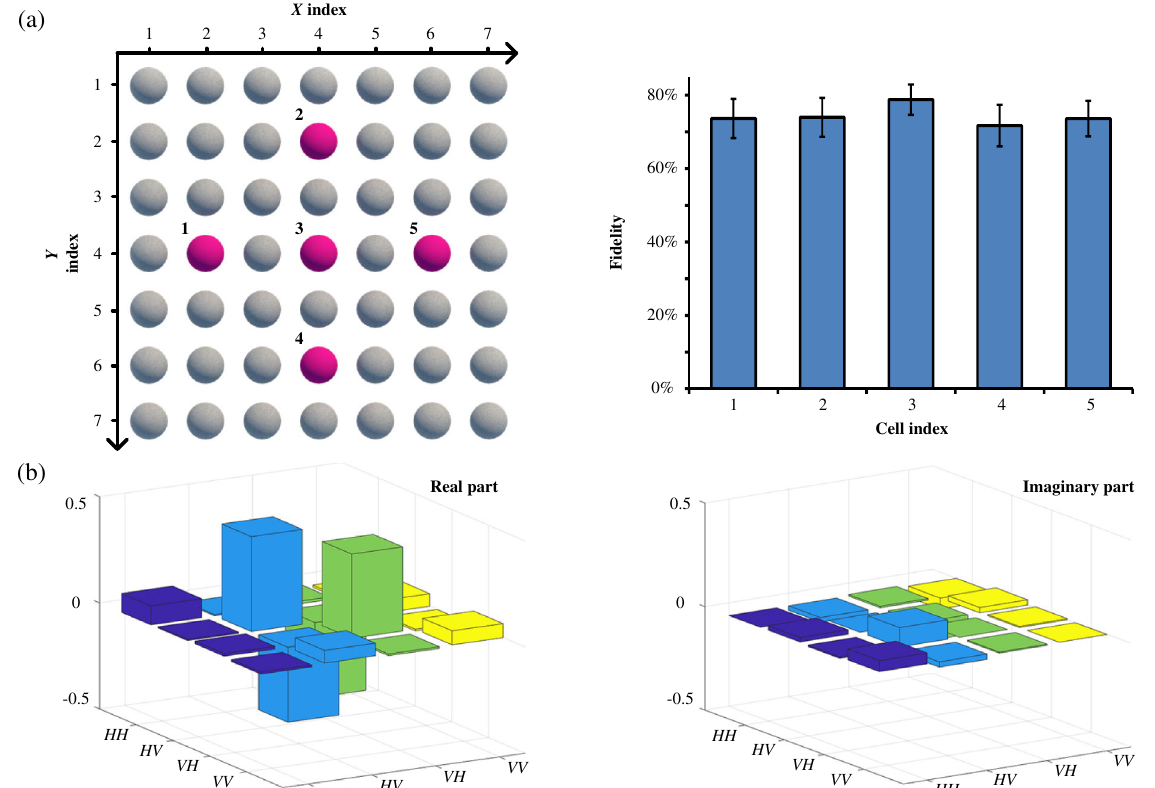
FIG. 3. Quantum entanglement between the retrieved photon from a memory cell and the signal photon after 10-km transmission. (a) The measured entanglement fidelity for the retrieved photon after storage in a chosen memory cell and the signal photon after 10-km transmission. The positions of the chosen memory cells in the 2D array are shown in the left part. A entanglement fidelity larger than 50% is a witness for entanglement [27]. (b) The reconstructed density matrix for the photon retrieved from the central memory cell (cell 3) and the signal photon after 10-km transmission. The fidelity is ð 78 . 8 (cid:2) 3 . 7 Þ % , and the storage fidelity is ð 89 . 6 (cid:2) 3 . 8 Þ % .